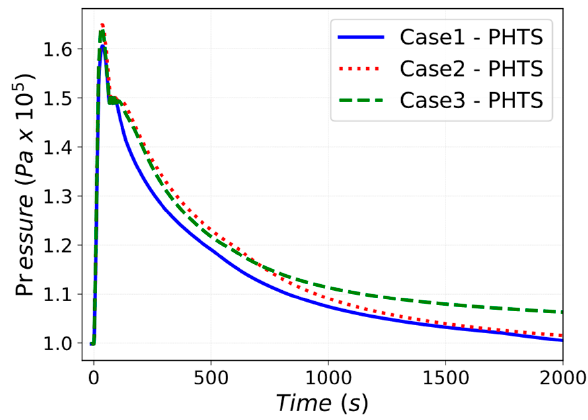
Figure 11. Pressure in the PHTS area.